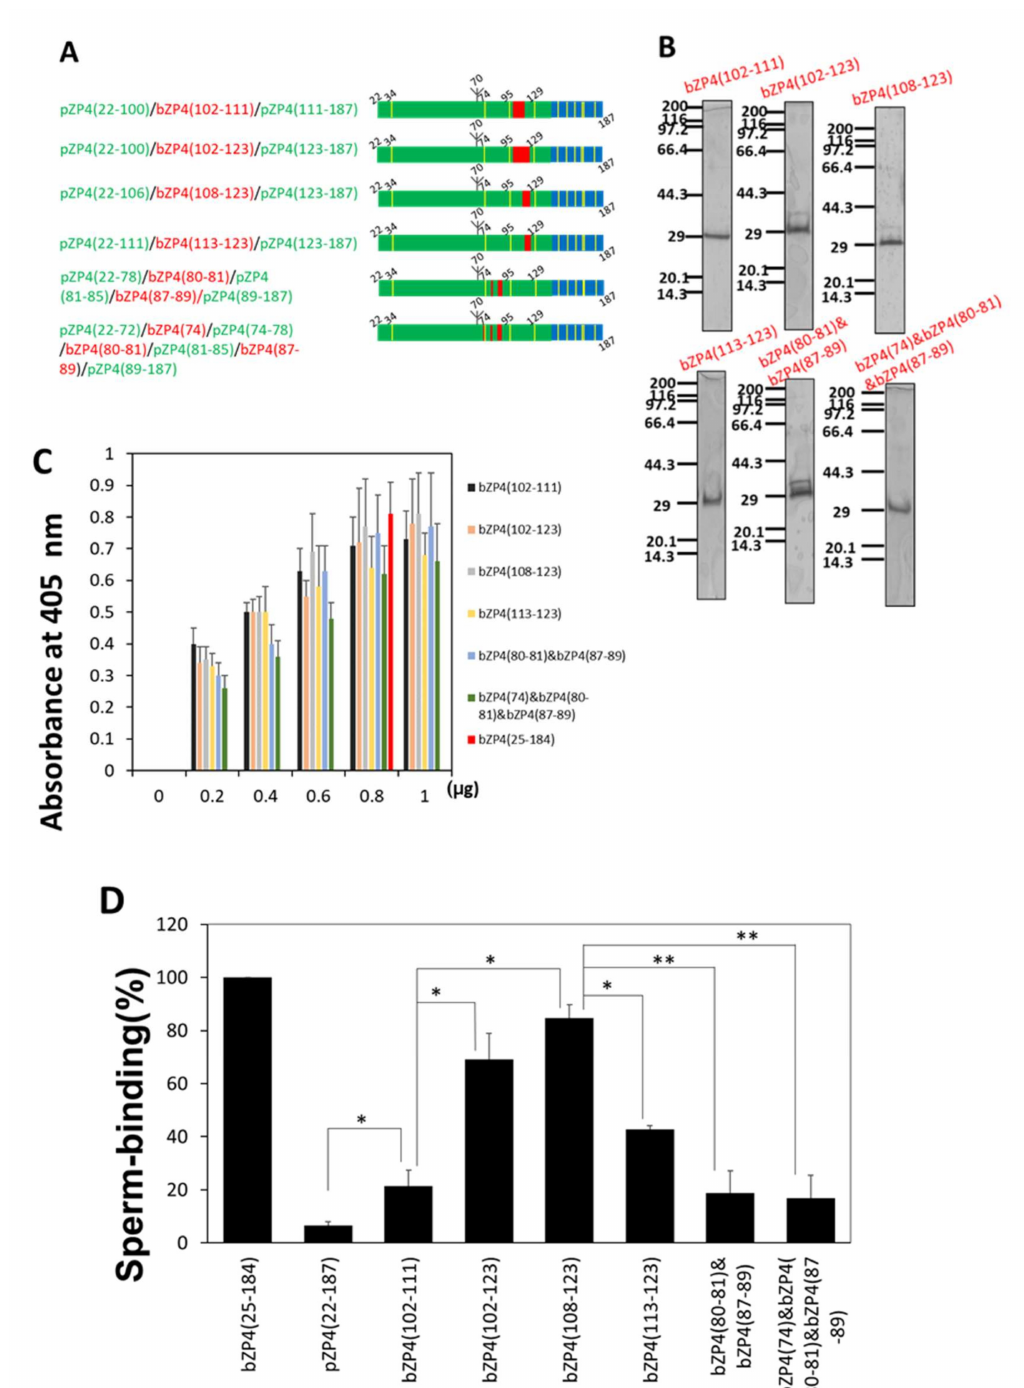
Figure 4. Sperm-binding sites in the C-terminal half of the ZP-N1 domain of bZP4. ( A ) Schematic of bovine (red) and porcine (green) chimeric proteins in which bovine ZP4 (102–111), ZP4 (102–123), ZP4 (108–123), ZP4 (113–123), both of ZP4 (80–81) and ZP4 (87–89), and both of ZP4 (80–81) and ZP4 (87–89) with ZP4 (74) replace the corresponding porcine sequences. The trefoil domain derived from pZP4 is shown in blue and Cys residues are in yellow bars. ( B ) SDS-PAGE of each chimeric ZP4 protein shown in ( A ). The proteins in ( B – D ) are indicated by the bovine sequence region shown in